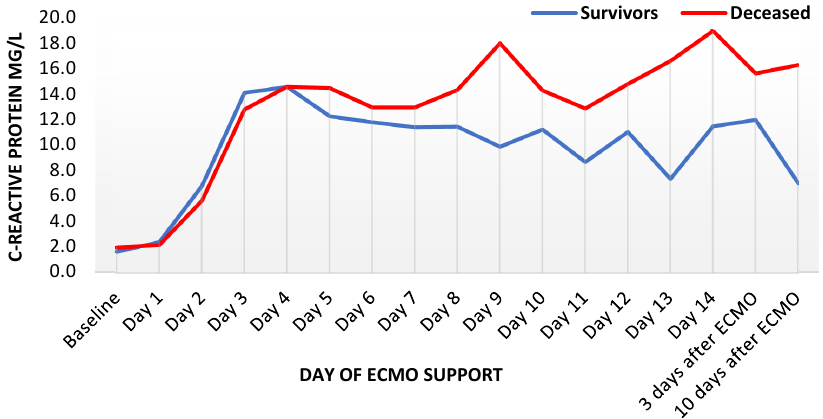
Figure 1. Trends of C-reactive protein levels during ECMO support, presented as median values ( n = 435). ECMO: extracorporeal membrane oxygenation.